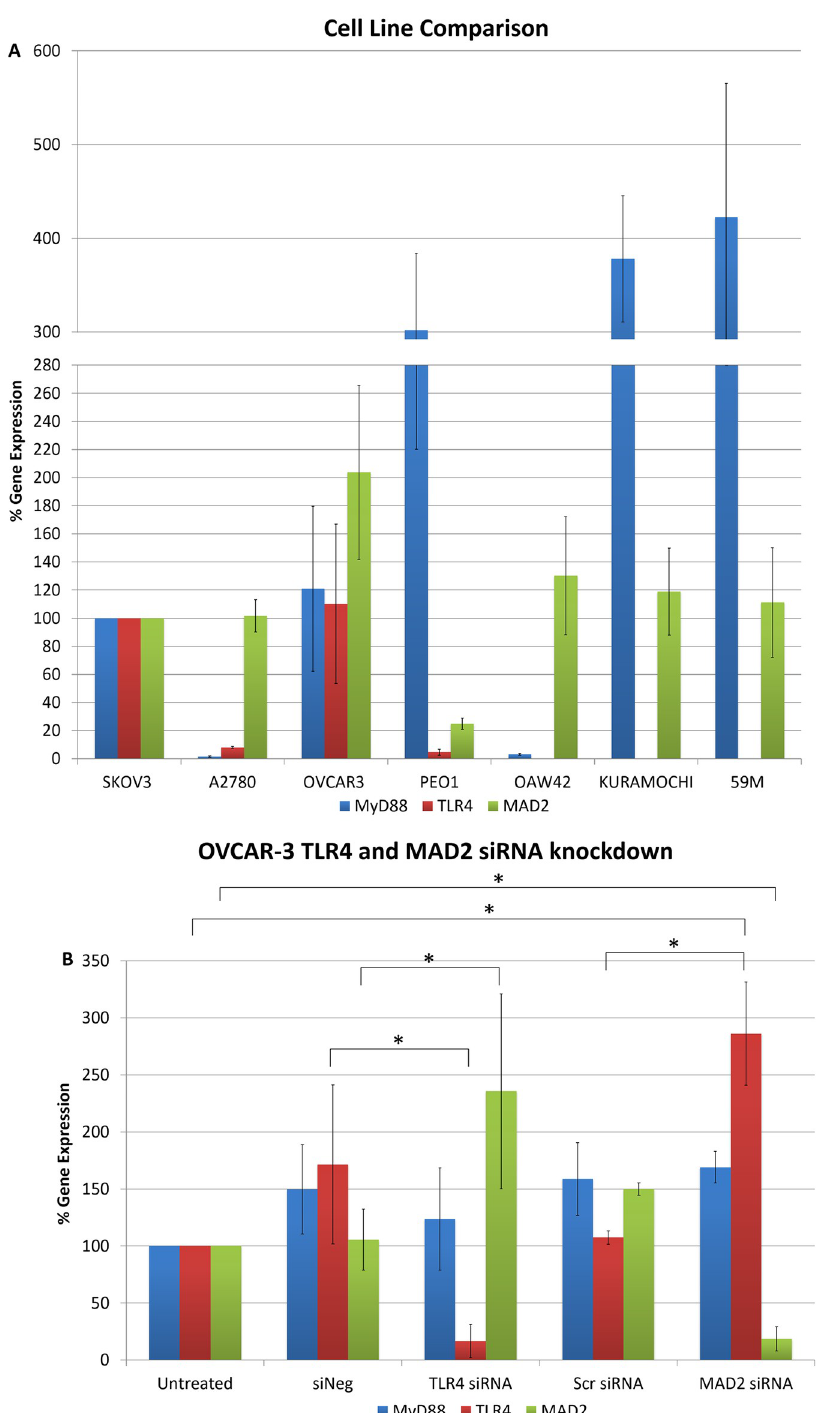
Fig 3. Cell line cross comparison and OVCAR-3 TLR4 and MAD2 siRNA knockdown. (A) MyD88, TLR4 and MAD2 gene expression in A2780, OVCAR-3, PEO1, OAW42, KURAMOCHI and 59M cells relative to SKOV-3 cells. (B) MyD88, TLR4 and MAD2 gene expression in OVCAR-3 cells following siRNA knockdown of TLR4 or MAD2. Gene expression levels were normalised to the endogenous control GAPDH and calibrated to that of untreated cells to establish the relative change in gene